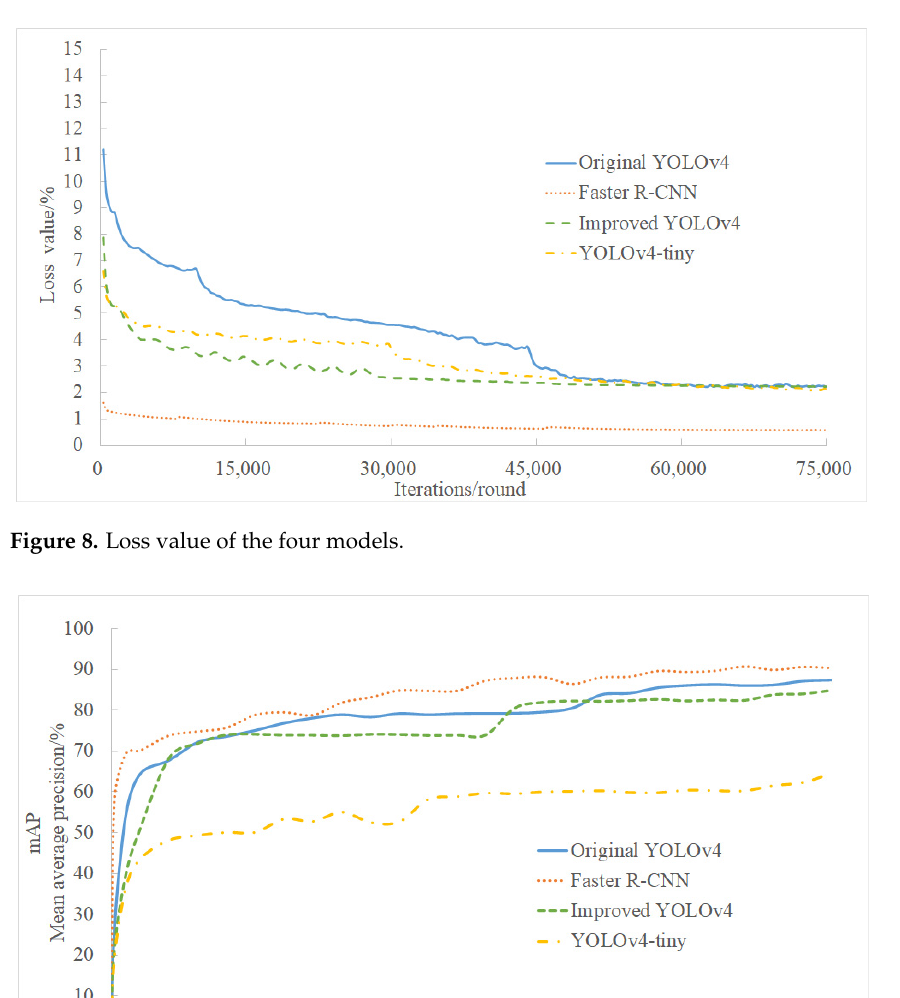
Figure 9. The mAP of the four